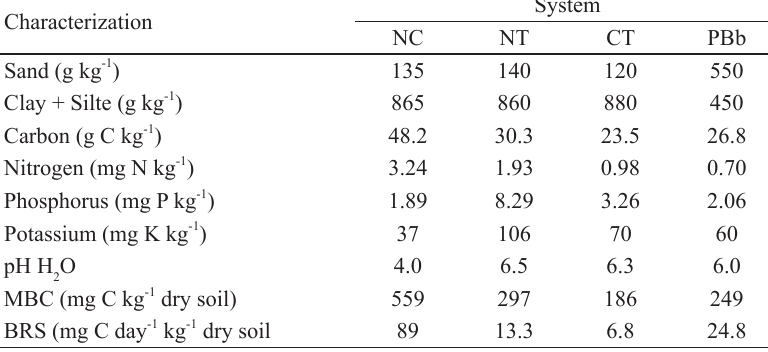
Physicochemical characteristics of soils under different land-use systems.